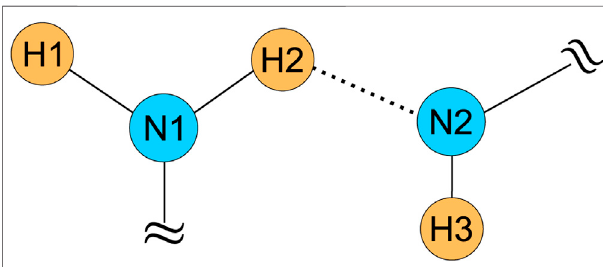
FIGURE 1 | The 5-spin system with two N and three H atoms complicating the 1 H- 14 N distance measurements by